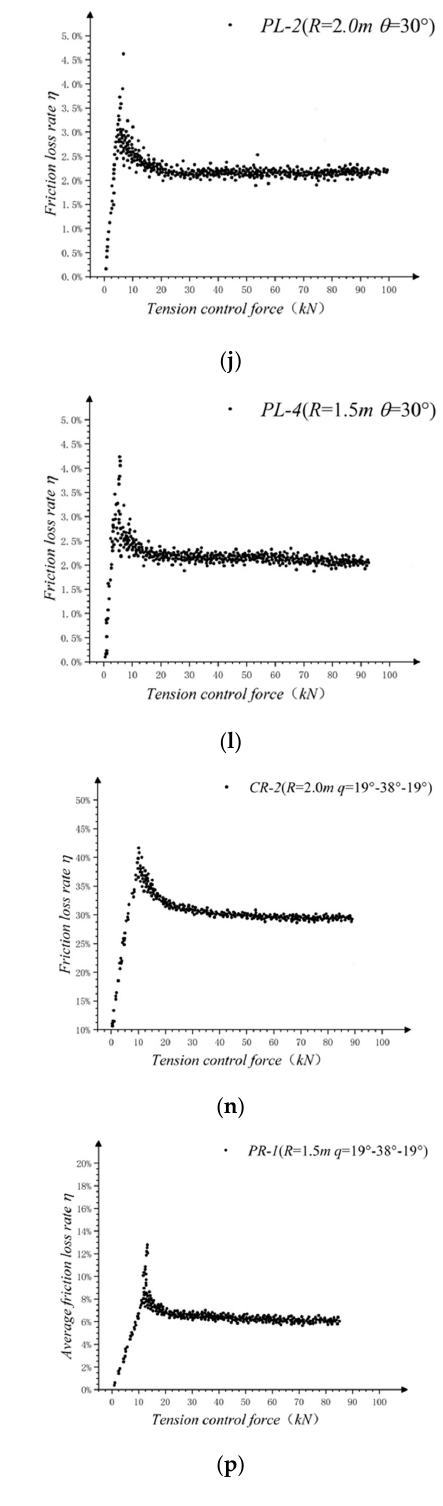
Figure 6. Scatter plot of friction loss rate: ( a ) CL ‐ 1; ( b ) CL ‐ 2; ( c ) CL ‐ 3; ( d ) CL ‐ 4; ( e ) ML ‐ 1; ( f ) ML ‐